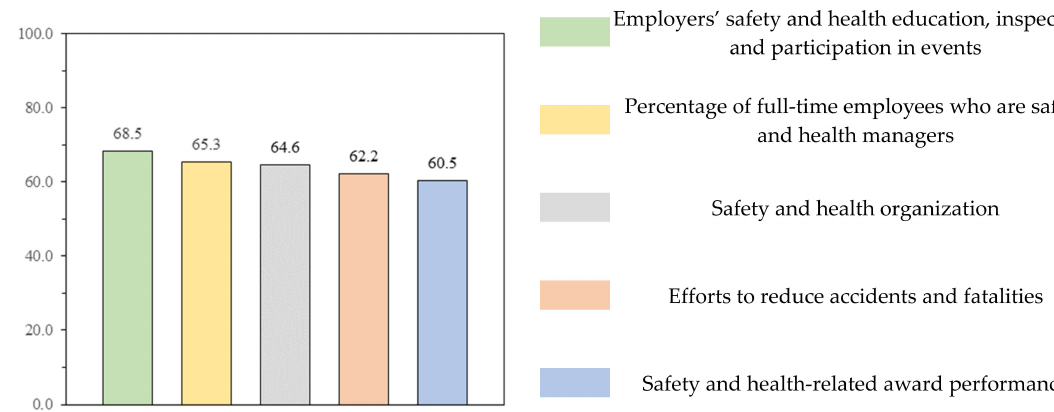
Figure 13. Survey weighted score for each item improvement